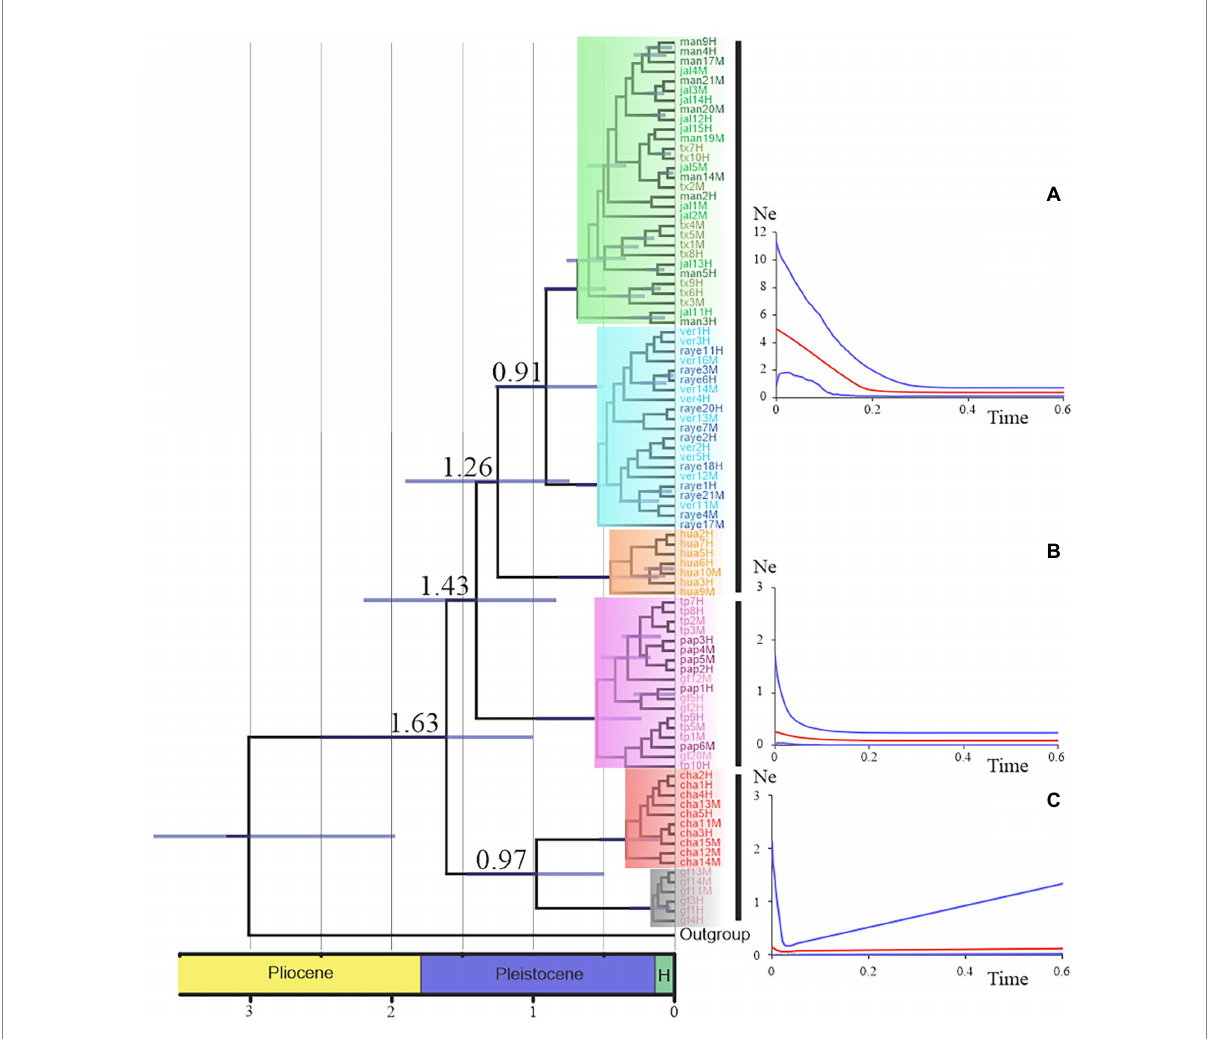
FIGURE 4 Chronogram and demographic history for the major clades were obtained by Nolasco-Soto et al. (2017). Time is in millions of years. Nodes with posterior probabilities above 0.9 show time uncertainty by means of 95% HPD bars. Skyland plots display the historical demographic tendency of the mayor lineages. The red line indicates the trend of the median Ne, whereas the blue lines represent the 95% confidence limits. (A) “Great lineage” demographic trend (Fu’s F s = − 31.01, p < 0.0001), (B) NGM clade demographic trend (Fu’s F s = − 4.75, p < 0.01), and (C) GF-Cha clade demographic trend (Fu’s F s = 4.99, p <